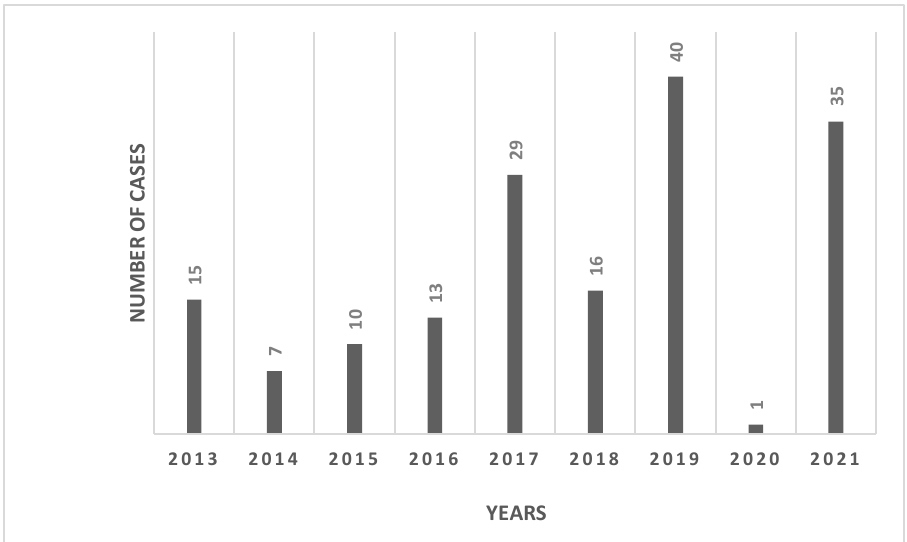
Figure 1. Distributions of dengue fever cases in Qatar, 2013–2021.